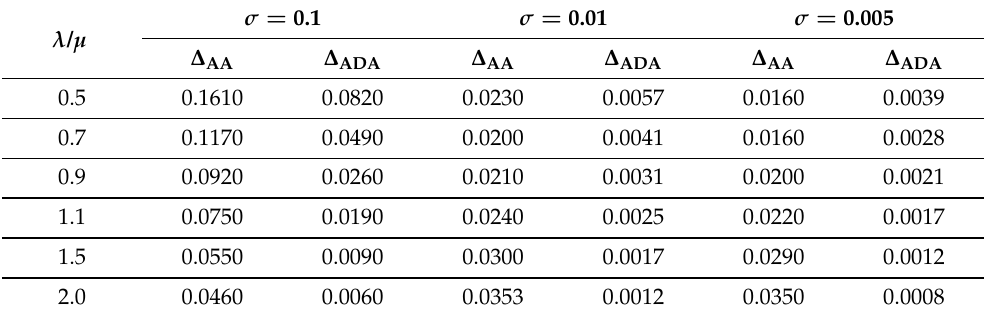
Table 1. Kolmogorov